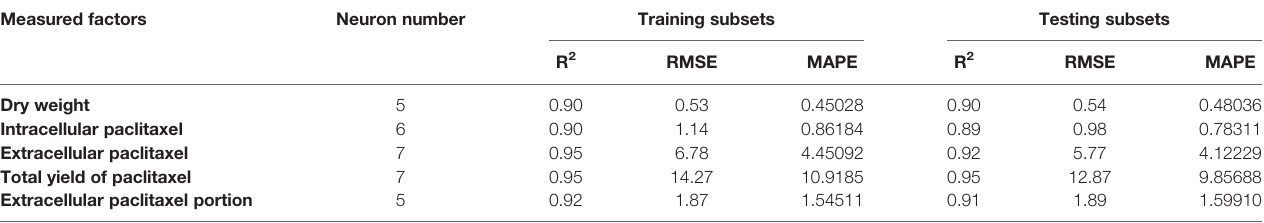
TABLE 2 | Statistics and information on multilayer perceptron-genetics algorithm (MLP-GA) models for growth, paclitaxel biosynthesis and secretion in Corylus avellana cell culture.